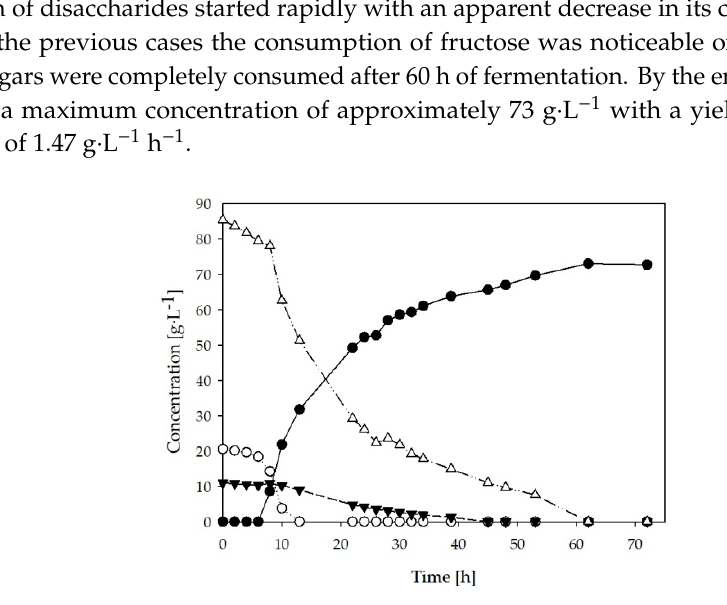
); fructose (cid:72) ; (cid:35)